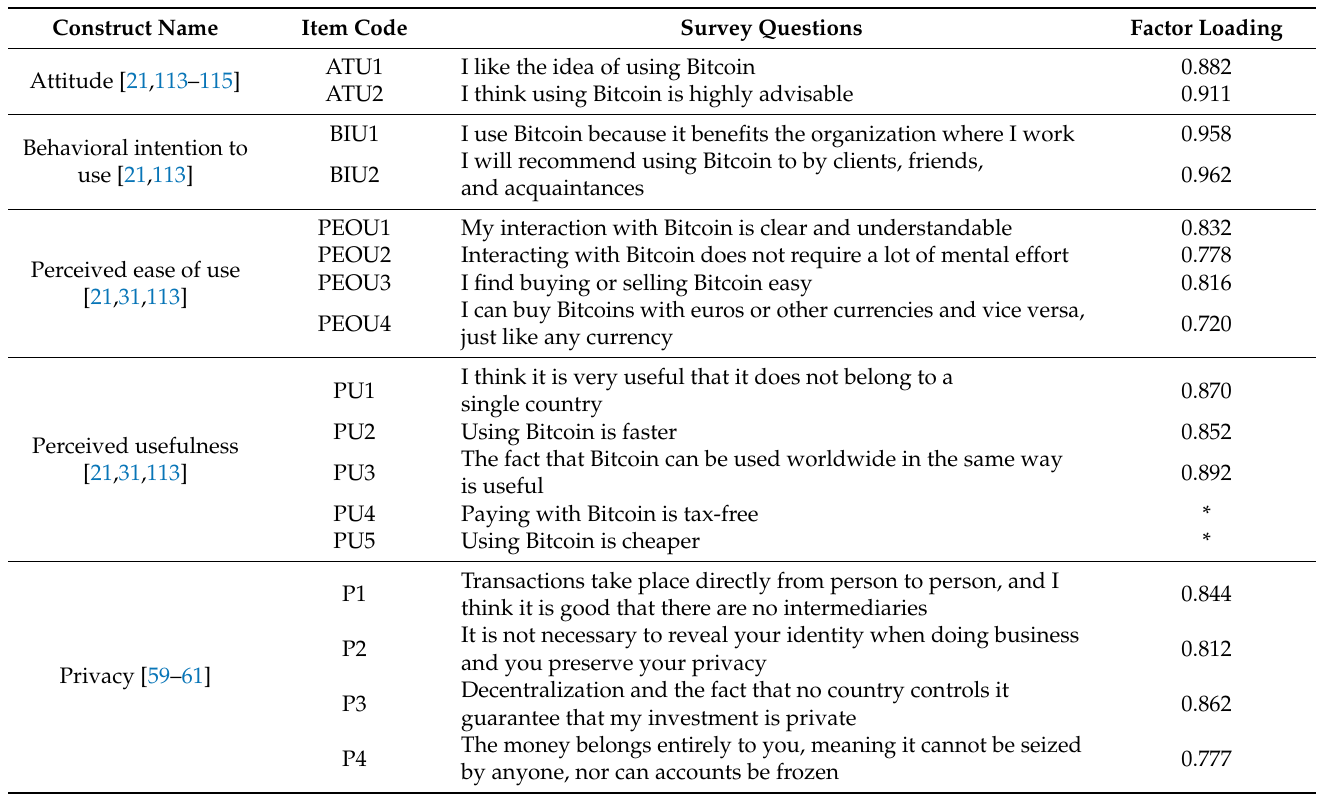
Table A1. Survey questions and factor